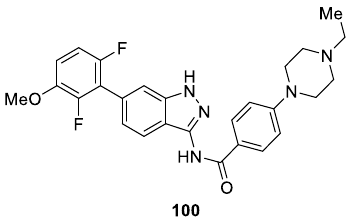
Figure 14. Chemical structure of 1 H -indazol-3-amine derivative 100 .